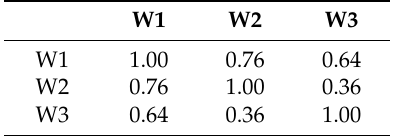
Table 7. The correlation matrix (modified IEEE 118-bus test system).